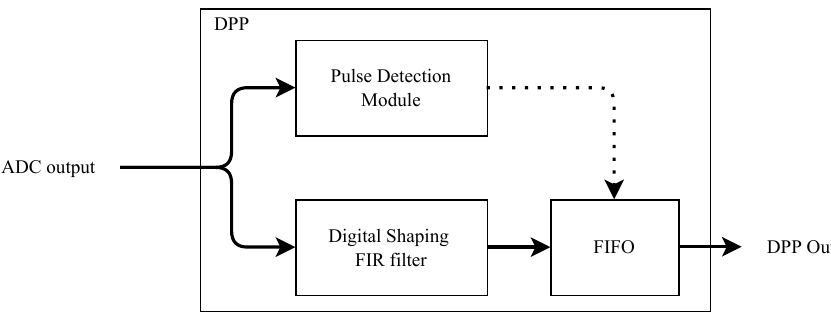
Figure 3. Simplified block diagram of the digital pulse-processing